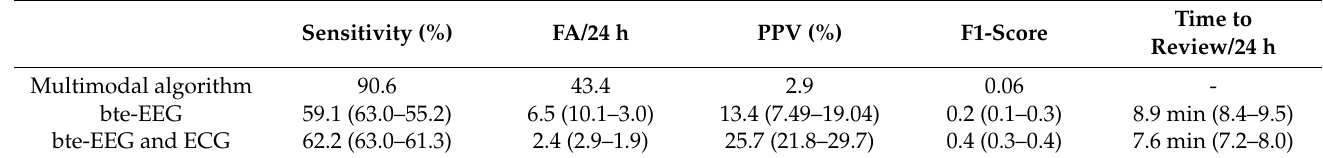
Table 2. Performance metrics of the readers (mean (reader 1–reader 2)) in each experimental setup (visual analysis of only bte-EEG and bte-EEG together with ECG and heart rate data) and the multimodal seizure detection